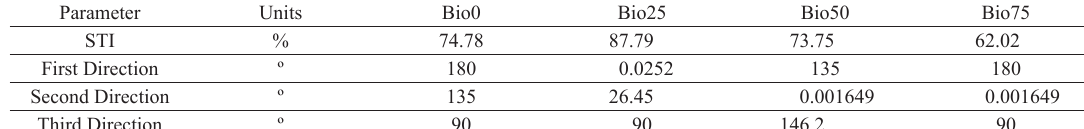
Table 3. Surface Texture Isotropy (STI) and their respective directions for more relevant analyzed samples.